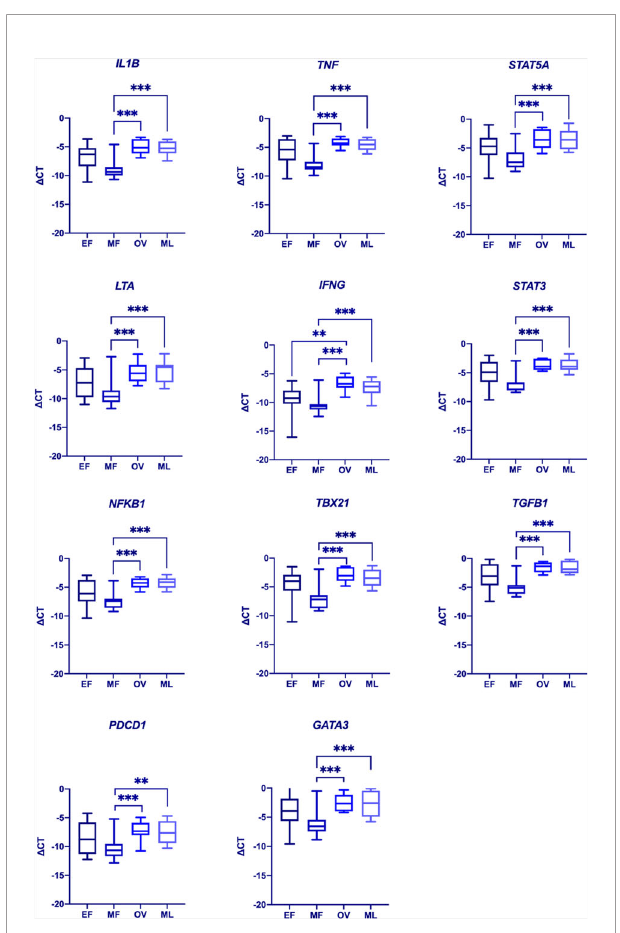
FIGURE 2 | Differences in immune gene expression during the menstrual cycle. A generalized mixed model (GLMM, a = 0.002) was used to determine differences in gene expression between the various menstrual cycle phases (EF, early follicular phase; MF, mid follicular phase; Ov, ovulatory phase; ML, mid luteal phase). Signi fi cant differences could be observed for IL1B , TNF , STAT5A , LTA , IFNG , STAT3 , NFKB1 , TBX21 , TGFB1 , PDCD1 , and GATA3 . Data represent medians ±0.975 quartiles at df=9 in a t-distribution. Whiskers represent min and max values. ** p = 0.001. *** p < 0.001. Complete list of p -values is included in Supplemental Table 2 .